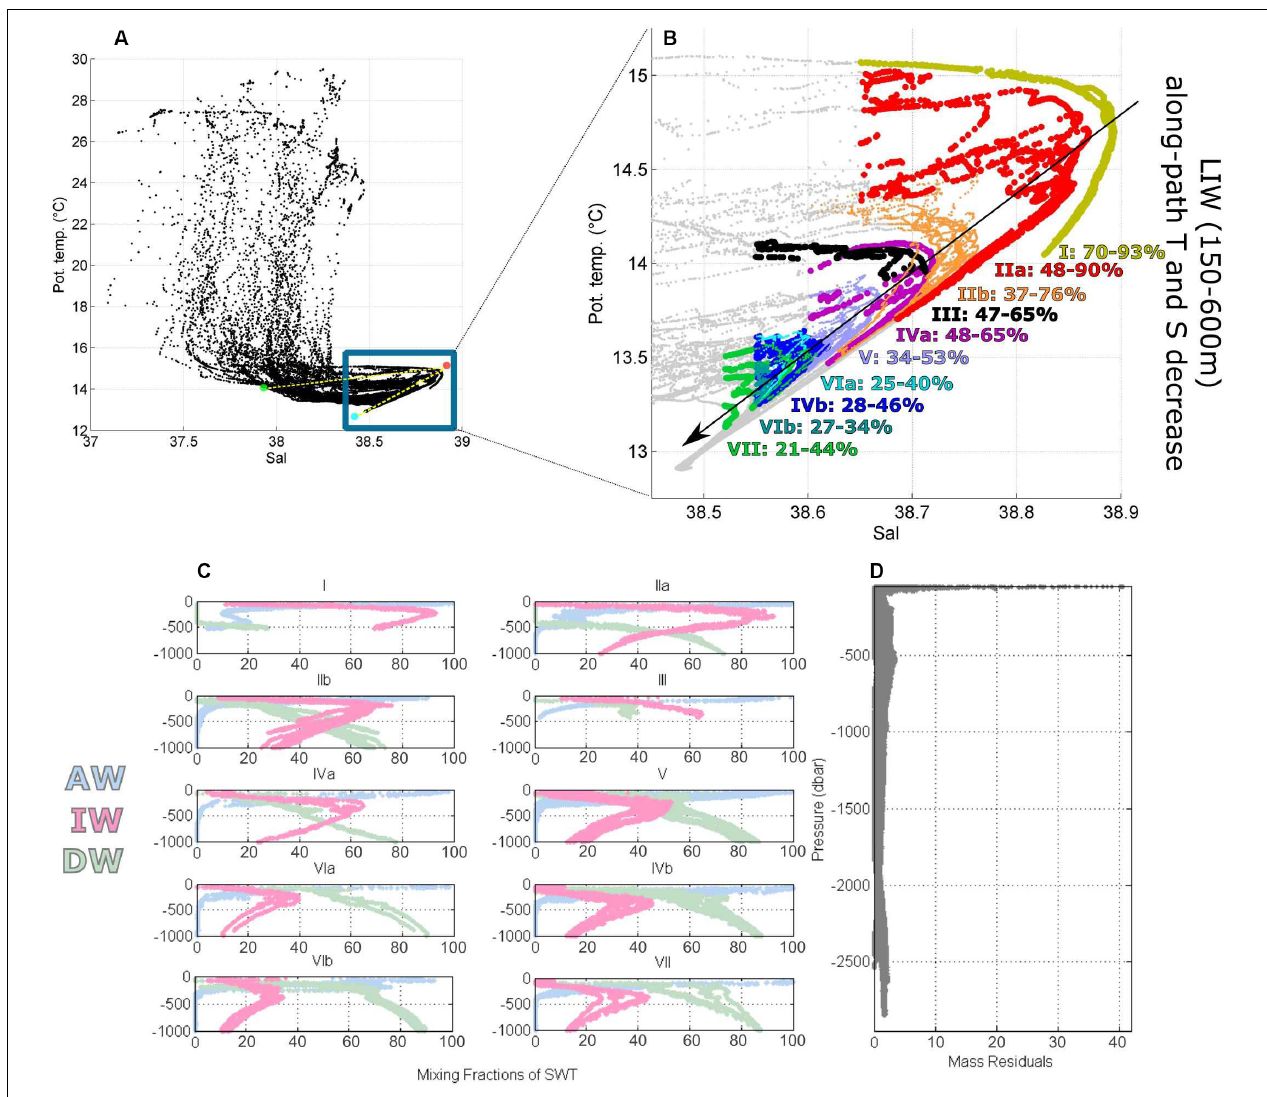
FIGURE 2 | (A) θ S diagram of the OC2015 cruise, and (B) zoom on the intermediate and deep layer. In (A) the three colored dots indicate the θ S properties of AW (green), IW (red) and DW (blue) used for the OMP analysis ( Table 1 ), yellow dashed lines represent the mixing lines between IW and AW, and between IW and DW. In (B) colored dots within the IW layer (150–600 m + additional salinity constraints) are shown according to colored transects in Figure 1 . Gray dots do not belong to IW. In addition, the percentage of IW within the core in each area is shown. (C) Vertical profiles of %AW, %IW and %DW in the different subregions; (D) vertical profile of mass residuals combining the results of the whole